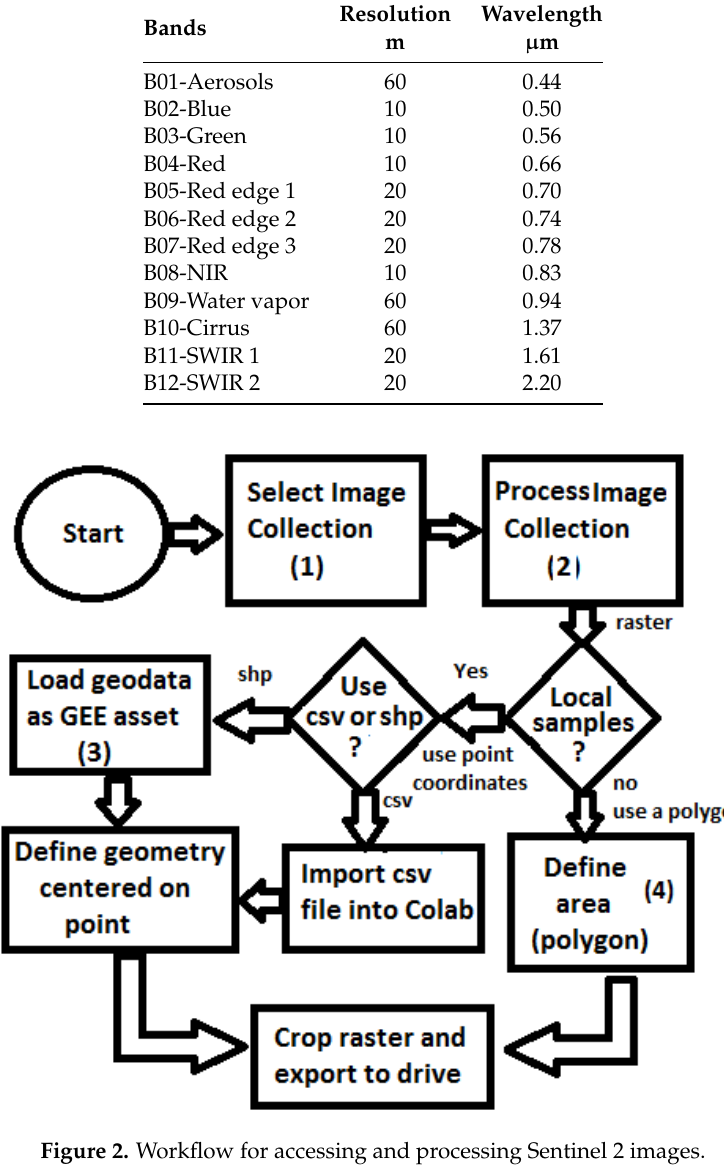
Figure 2. Workflow for accessing and processing Sentinel 2